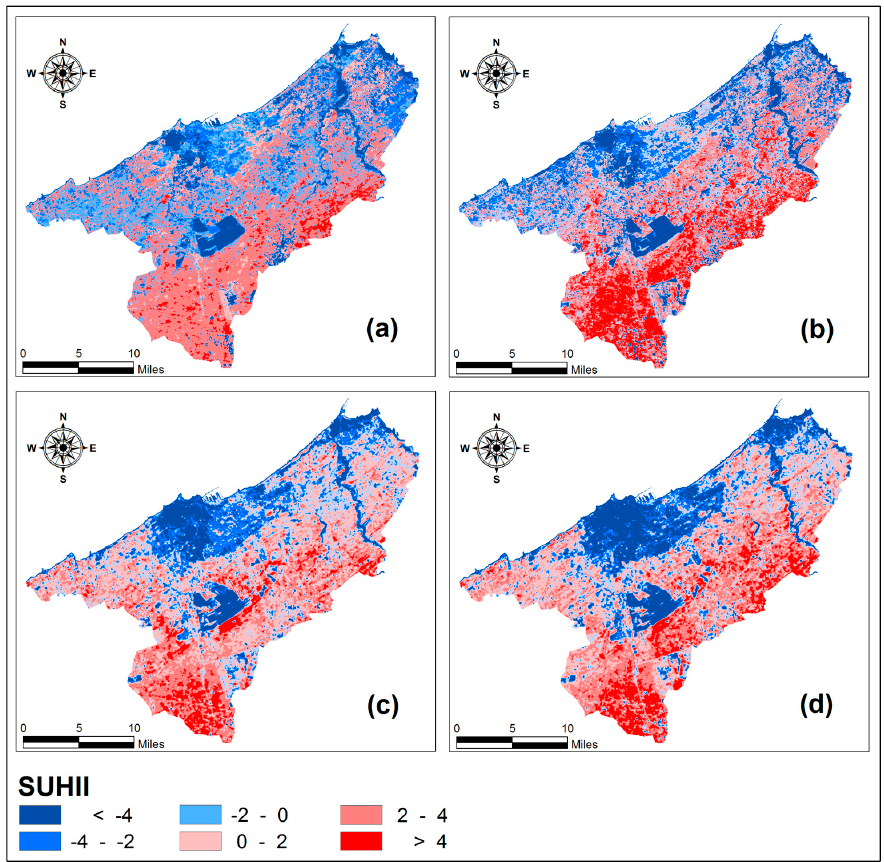
Figure 13 . Variation of daytime SUHII during the summer periods between 1984 and 2014: ( a ) SUHII of 25 August 1984 retrieved from TM; ( b ) SUHII of 30 August 2003 retrieved from TM; ( c ) SUHII of 24 June 2013 retrieved from OLI/TIRS; and ( d ) SUHII of 12 August 2014 retrieved from OLI/TIRS. The presence of cool islands in the city was reported in several urban climate studies [50].